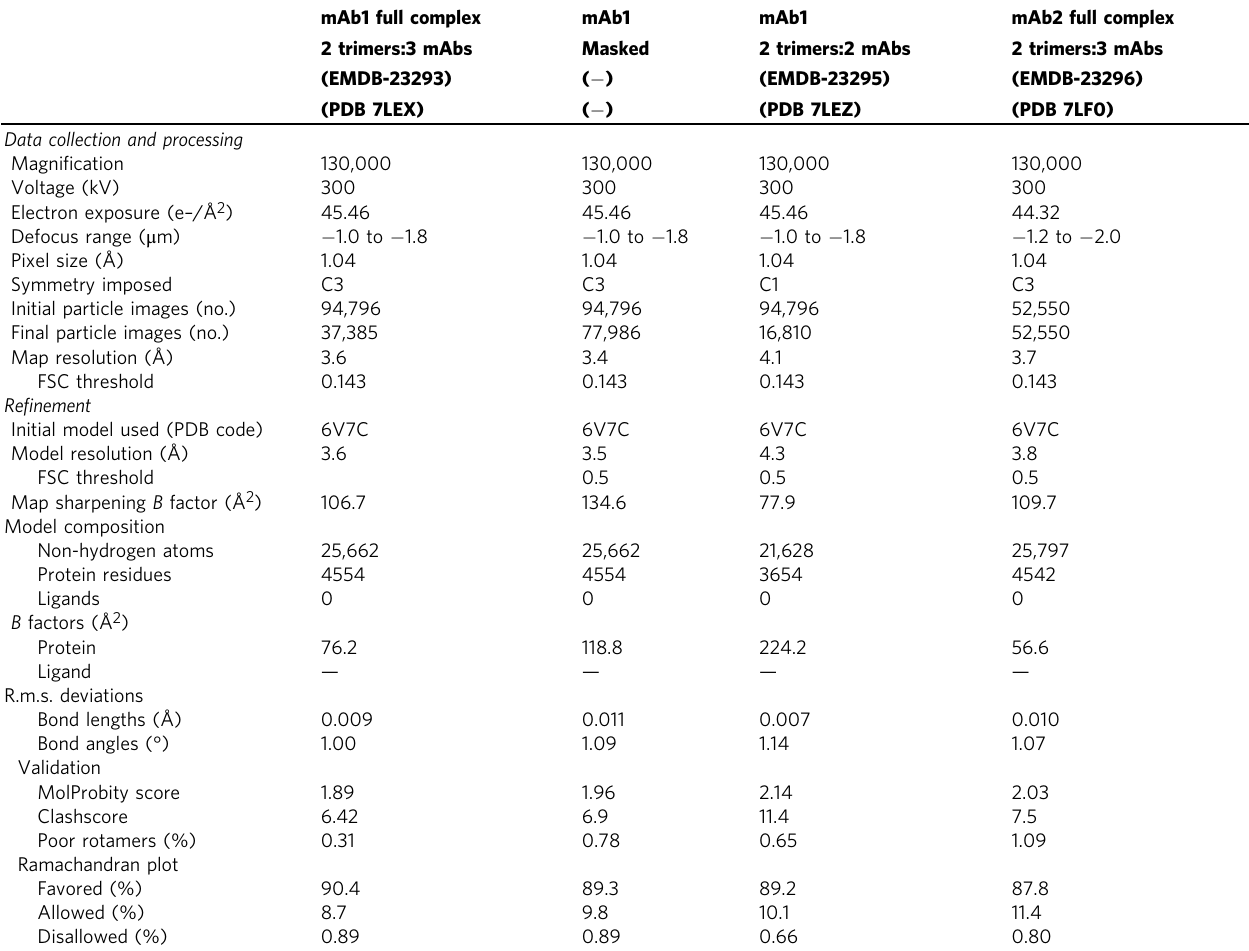
Table 1 Cryo-EM data collection, re fi nement and validation statistics for mAb1 and mAb2